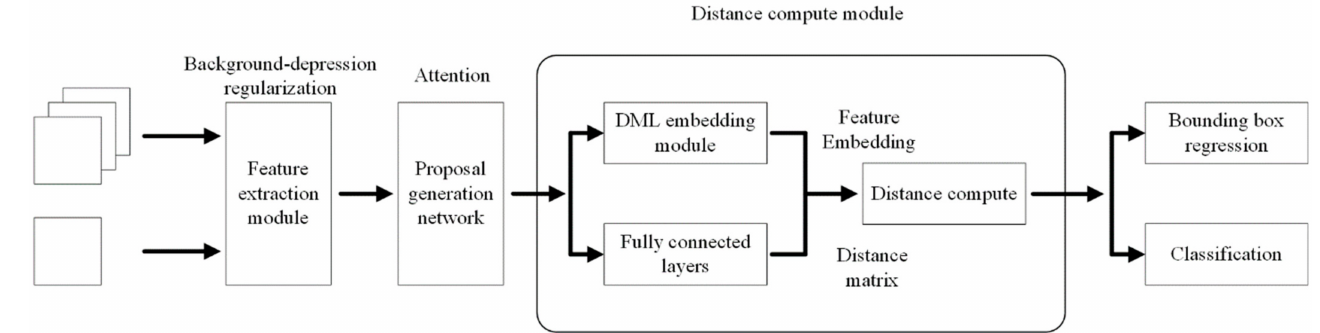
Figure 3. Network structure of the few-shot surface object detection method based on metric